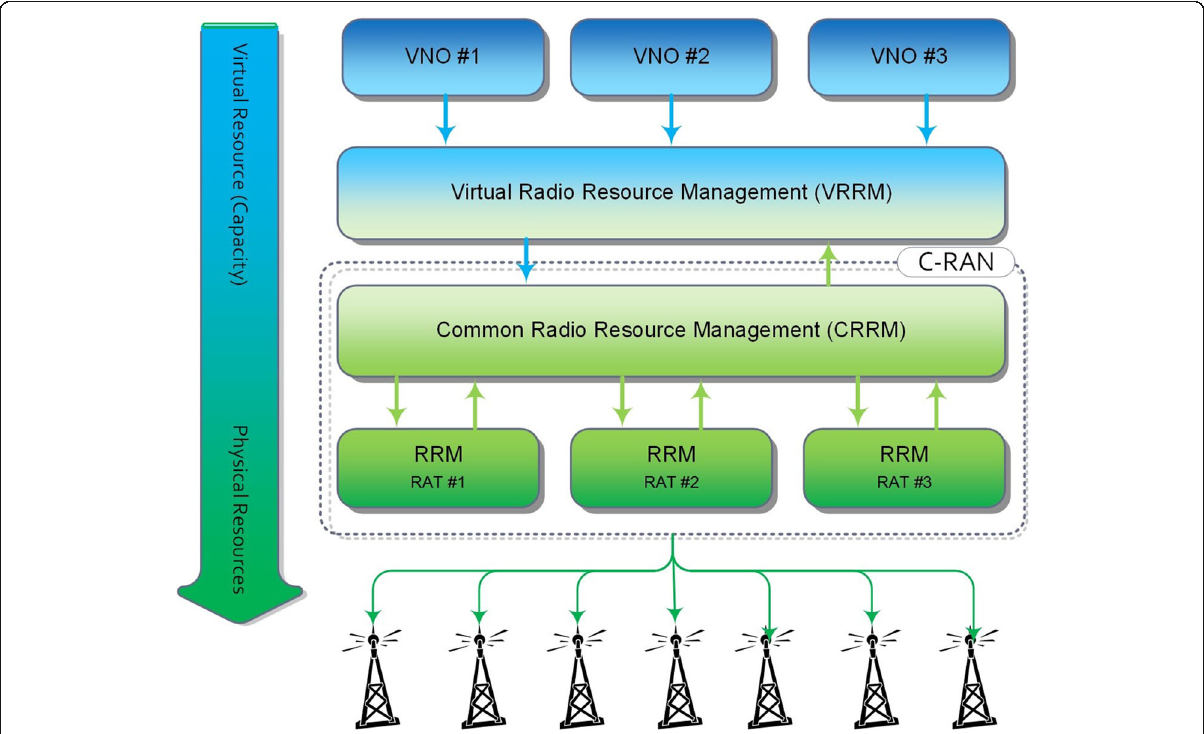
Fig. 1 Radio resource management in virtual RANs